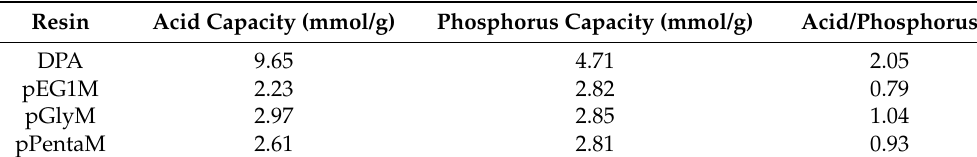
Table 1. Acid and phosphorus capacities of phosphonic acid and monoprotic polymers.